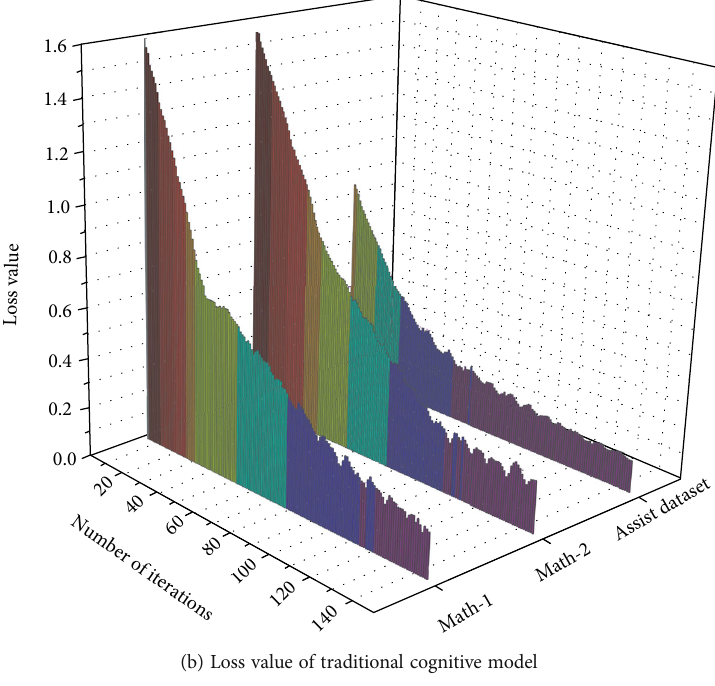
(b) Loss value of traditional cognitive model Figure 5: